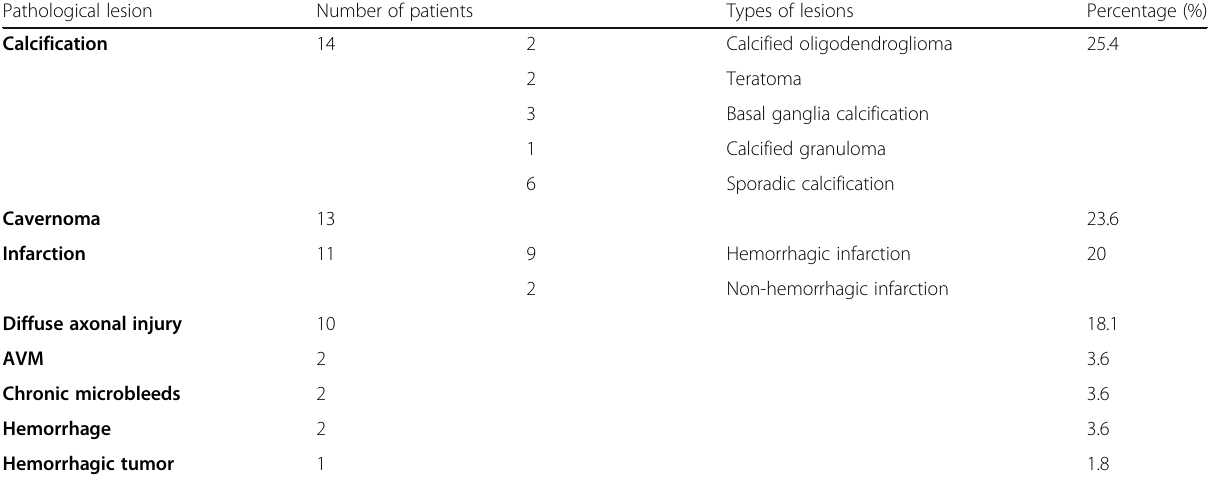
Table 1 Types of pathological lesions included in the current study Pathological